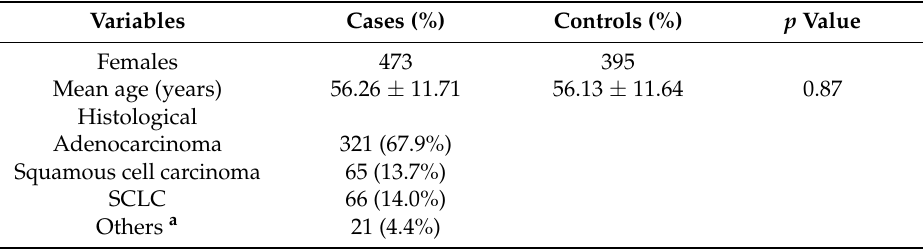
The observed genotype frequencies for each